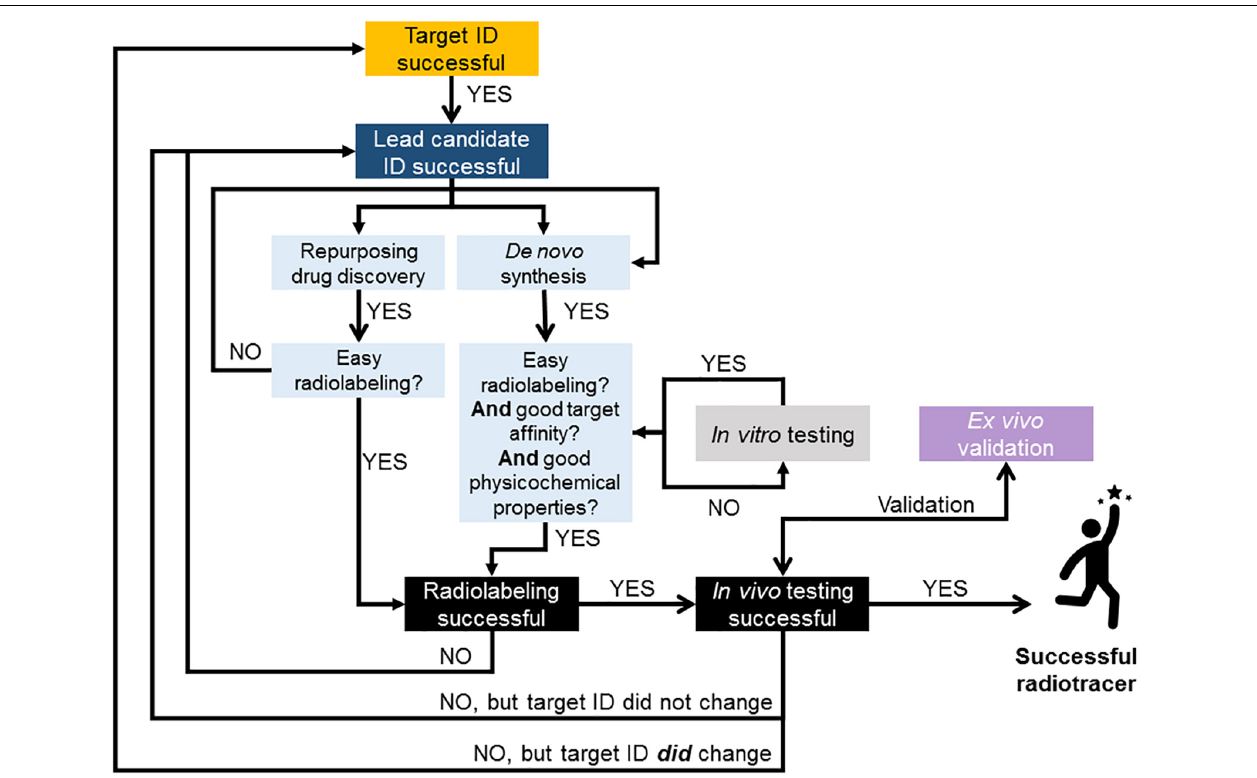
FIGURE 5 | Flow chart illustrating suggested approach to radiotracer discovery and development. Decision points based on literature reviewed in this paper and experience in brain radiotracer development. This illustrates the iterative nature of the process and provides guidance on strategies for successful translation of novel compounds into humans. When possible, repurposing compounds from drug discovery pipelines as potential radiotracer candidates can be advantageous to rapidly and successfully develop new PET and SPECT radiotracers for imaging the human brain. In case of de novo chemistry, all in vitro testing should be conducted with the non-radioactive library of compounds. This could be done by employing high throughput screening methods for measuring novel compounds’ physicochemical properties (e.g., Figure 4 ) and affinity for target. The removal of in vitro testing of the radiolabeled compound (as per Figure 1 ) will also further accelerate the process.